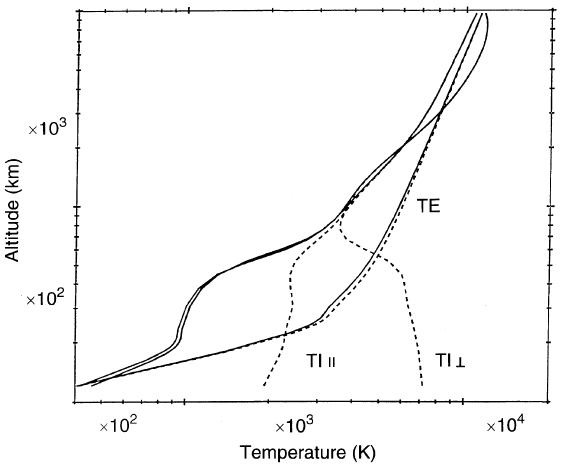
Fig. 6. Model electron and O (cid:135) anisotropic parallel ( T perpendicular ( T ? ) temperatures for no enhancement (—) and during the enhanced velocity event (- - -), at 9:23 UT, point A on the path